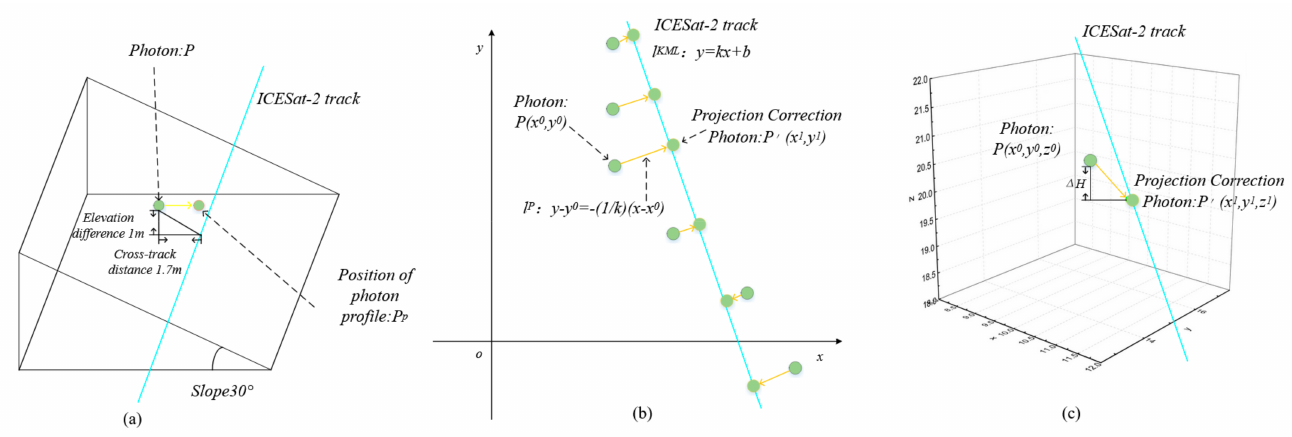
Figure 4. Schematic diagram of the cross-track photon error and correction diagram. ( a ) Cross-track photon error: when the slope is 30 ◦ , and the photon spans 1.73 m across the track, the point is converted to profile data distributed along the track, which is actually located 1 m above the track. This results in an overestimation of the elevation in the ground photon extraction. ( b ) Cross-track photon projection onto track. ( c ) Cross-track photon